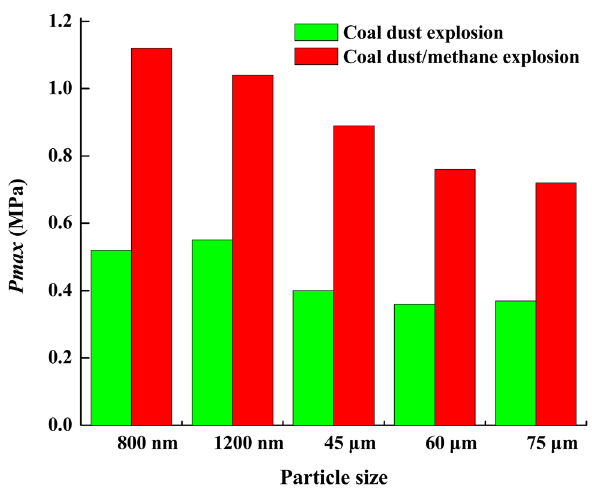
Fig. 14 Comparison of maximum